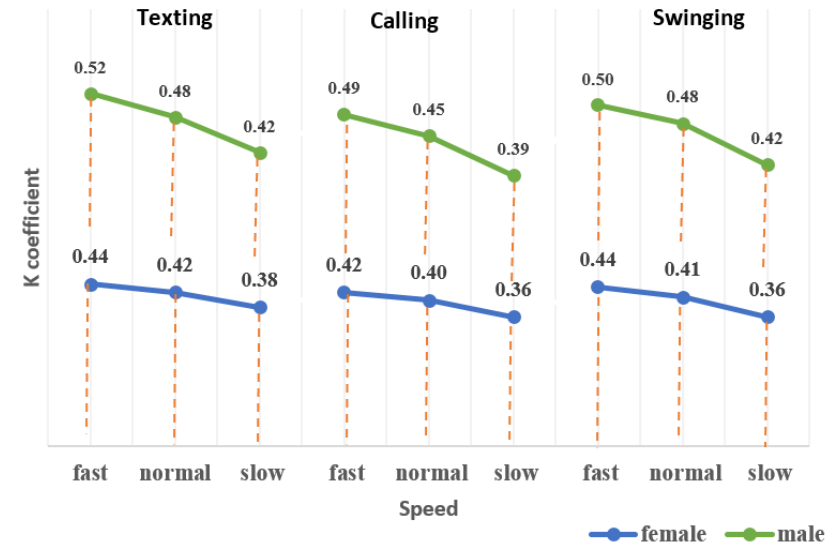
Figure 10. Estimated k